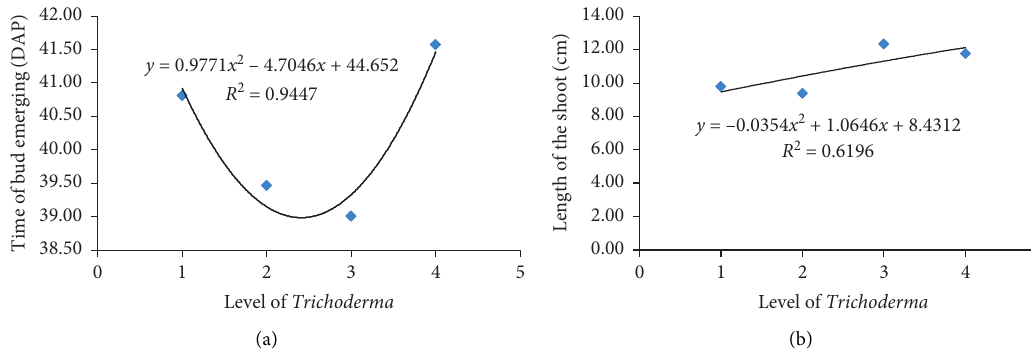
Figure 3: Regression analysis between the time of bud emerging (a) and length of the shoot (b) of pepper seedlings and doses of Trichoderma on pepper seedlings after 8 weeks of planting.